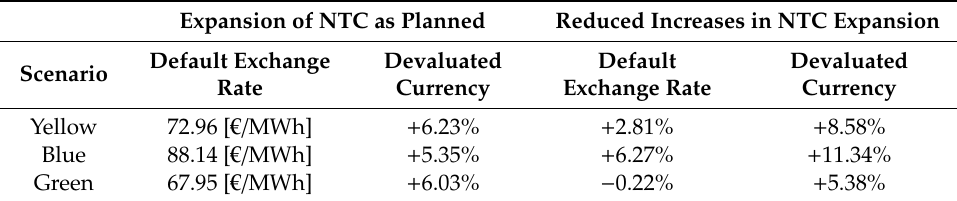
Table 5. Changes in wholesale prices. Source: Own